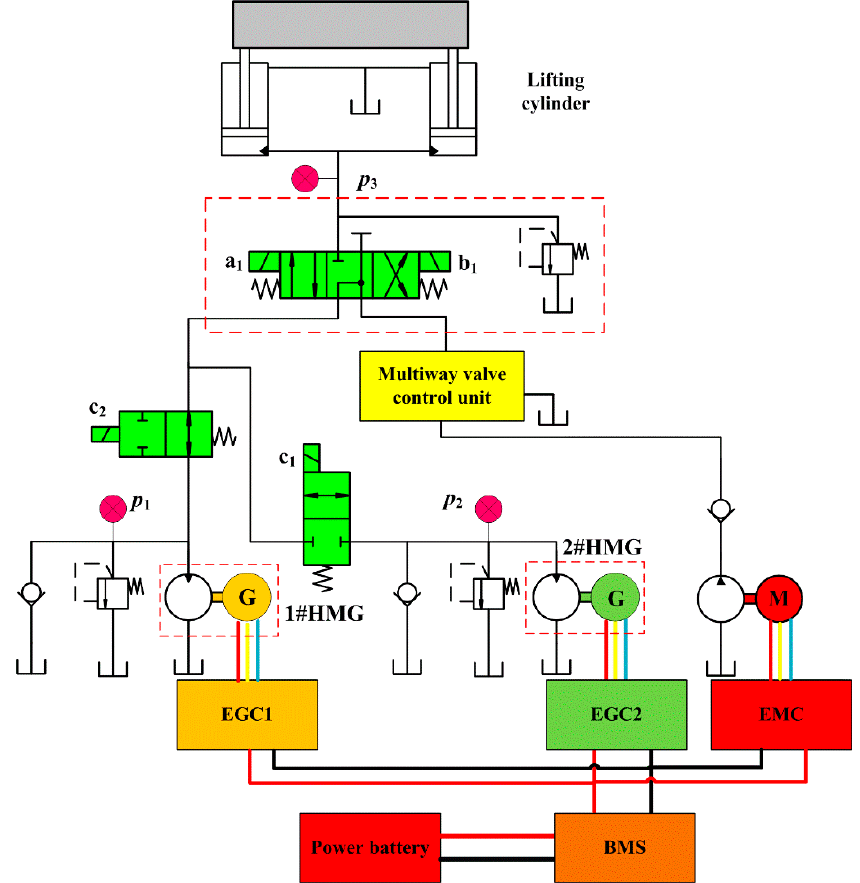
Figure 4. Schematic of the double motor-generators potential energy regeneration system (PERS).